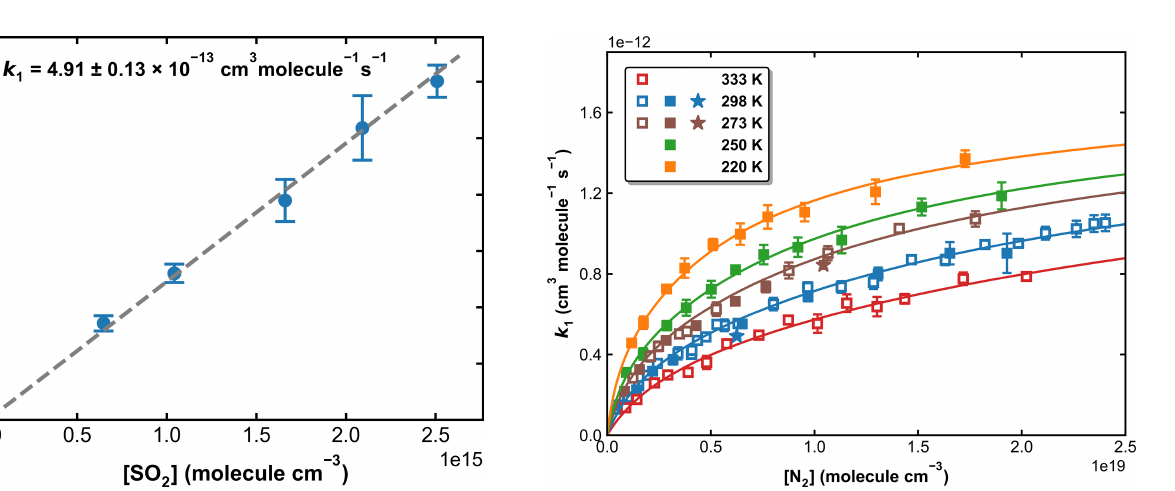
Figure 7. Pseudo-first-order rate coefficients ( k (cid:48) ) at 193.2Torr and 298K, whereby OH was generated by the 351nm photolysis of HONO. The time-dependent OH decay constants in the absence of SO 2 (blue symbols) were fit to a second-degree polynomial (dashed black lines). The number on the top of each data point when SO 2 is present (red-, green-, orange-, purple-, and olive-coloured symbols) represents the difference in k (cid:48) to that obtained (by interpolation) in the absence of SO 2 . A few drops of the NaNO 2 solution were re-added after about 90min to maintain OH levels and thus a good signal-to-noise ratio.